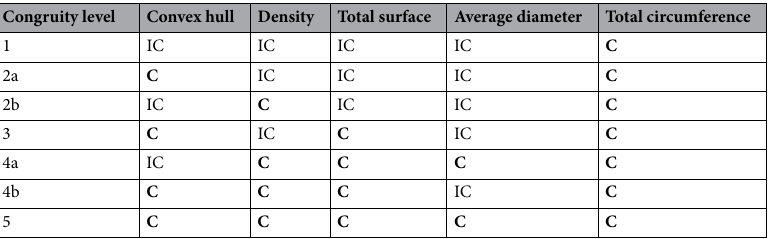
Table 1. Different congruity levels. C congruent with number, IC incongruent with number. The congruent magnitudes are in bold